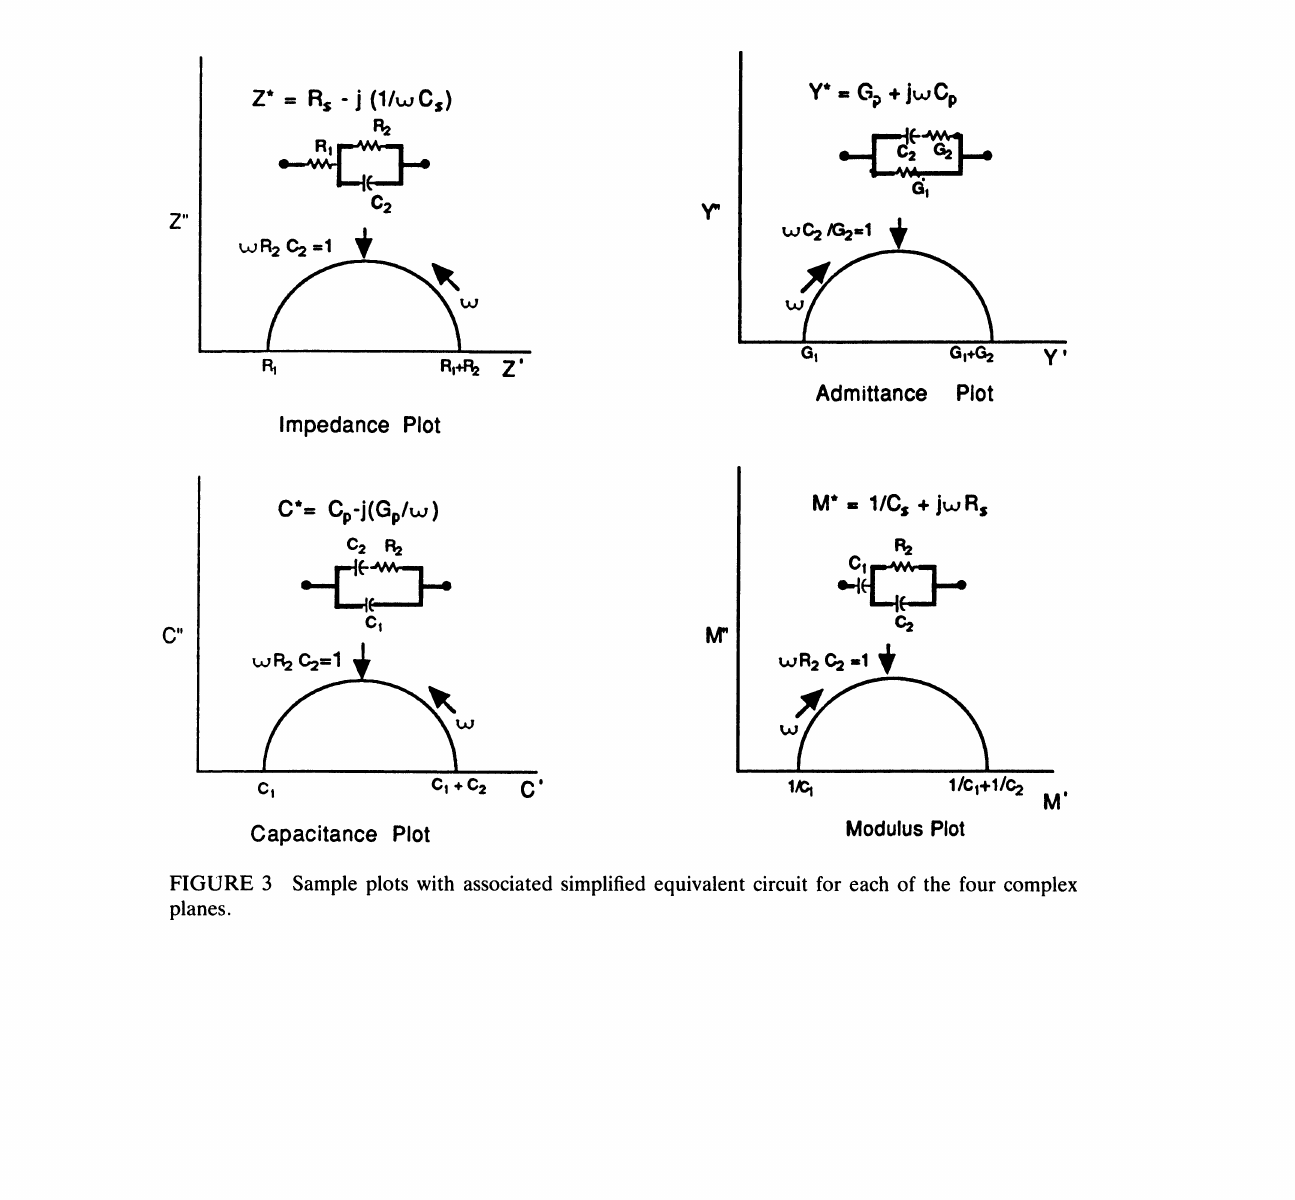
FIGURE 3 Sample plots with associated simplified equivalent circuit for each of the four complex